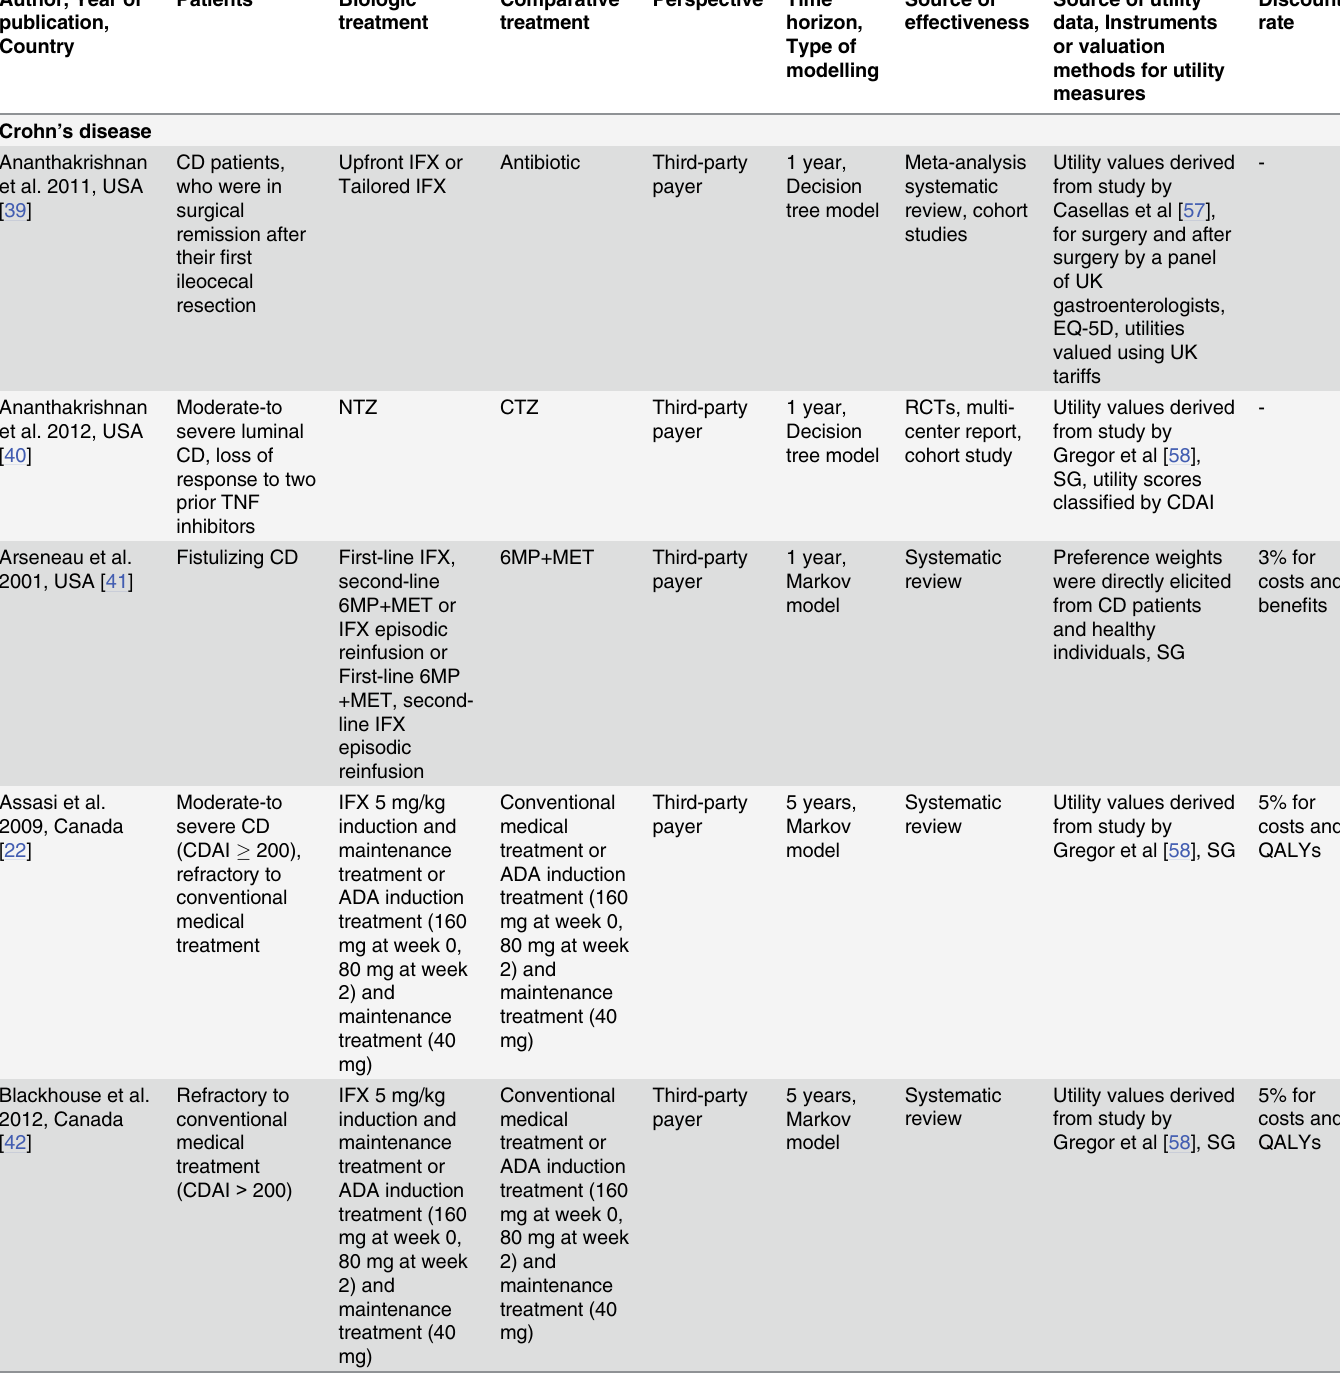
Table 1. Characteristics of the